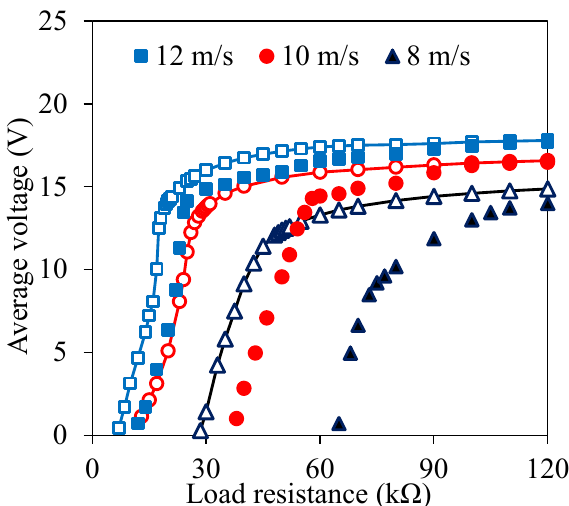
Figure 12. Variation of the average (RMS) voltage with the external load resistance for different wind velocities (solid symbols: measured; lines with empty symbols: simulated).